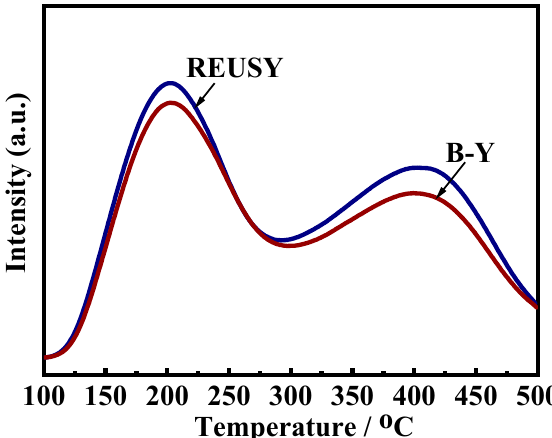
Figure 2. NH 3 -TPD profiles of REUSY and B-Y.